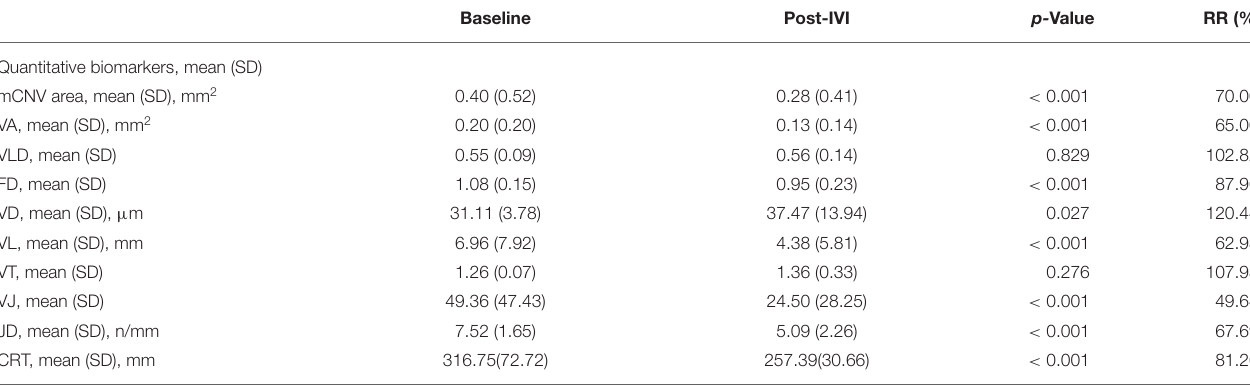
TABLE 3 | Quantitative biomarkers of the optical coherence tomography angiography for myopic choroidal neovascularization. Baseline Post-IVI Quantitative biomarkers, mean